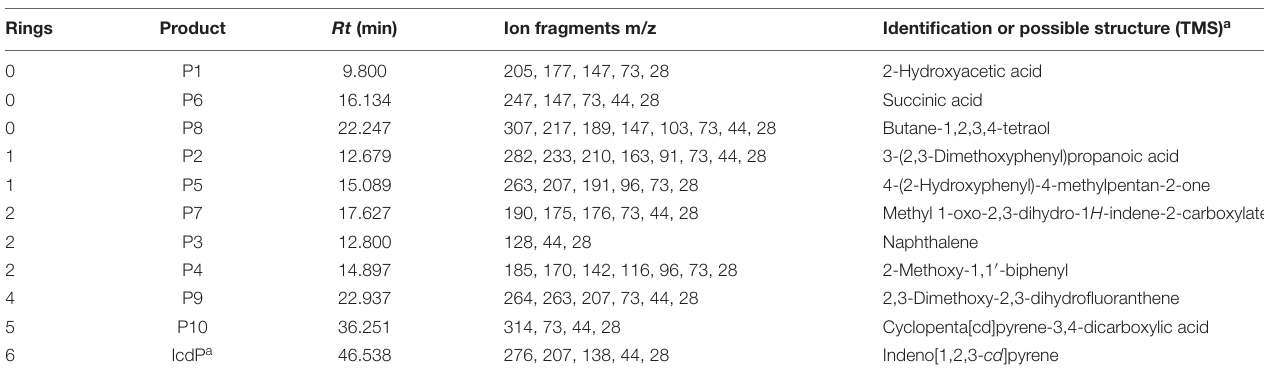
TABLE 2 | Intermediates formed in the degradation of IcdP by strain